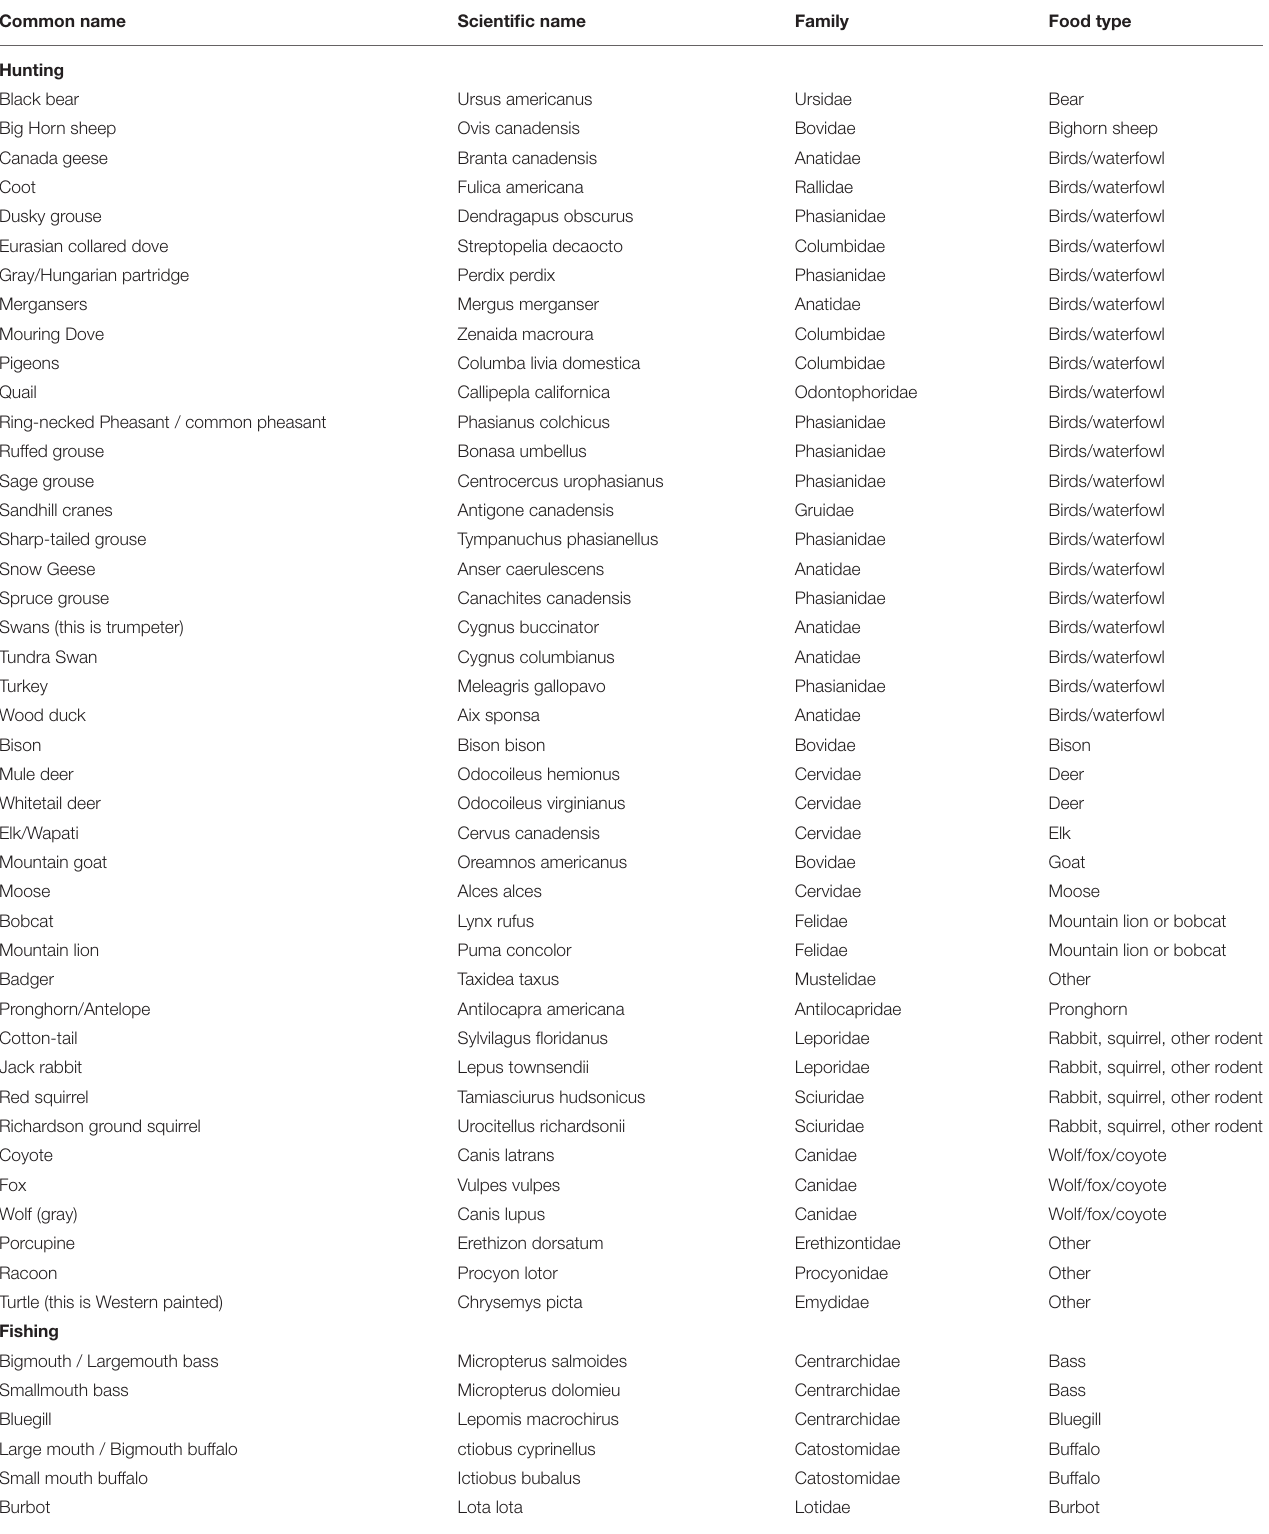
TABLE 2 | Types of wild foods procured through hunting, fishing, and